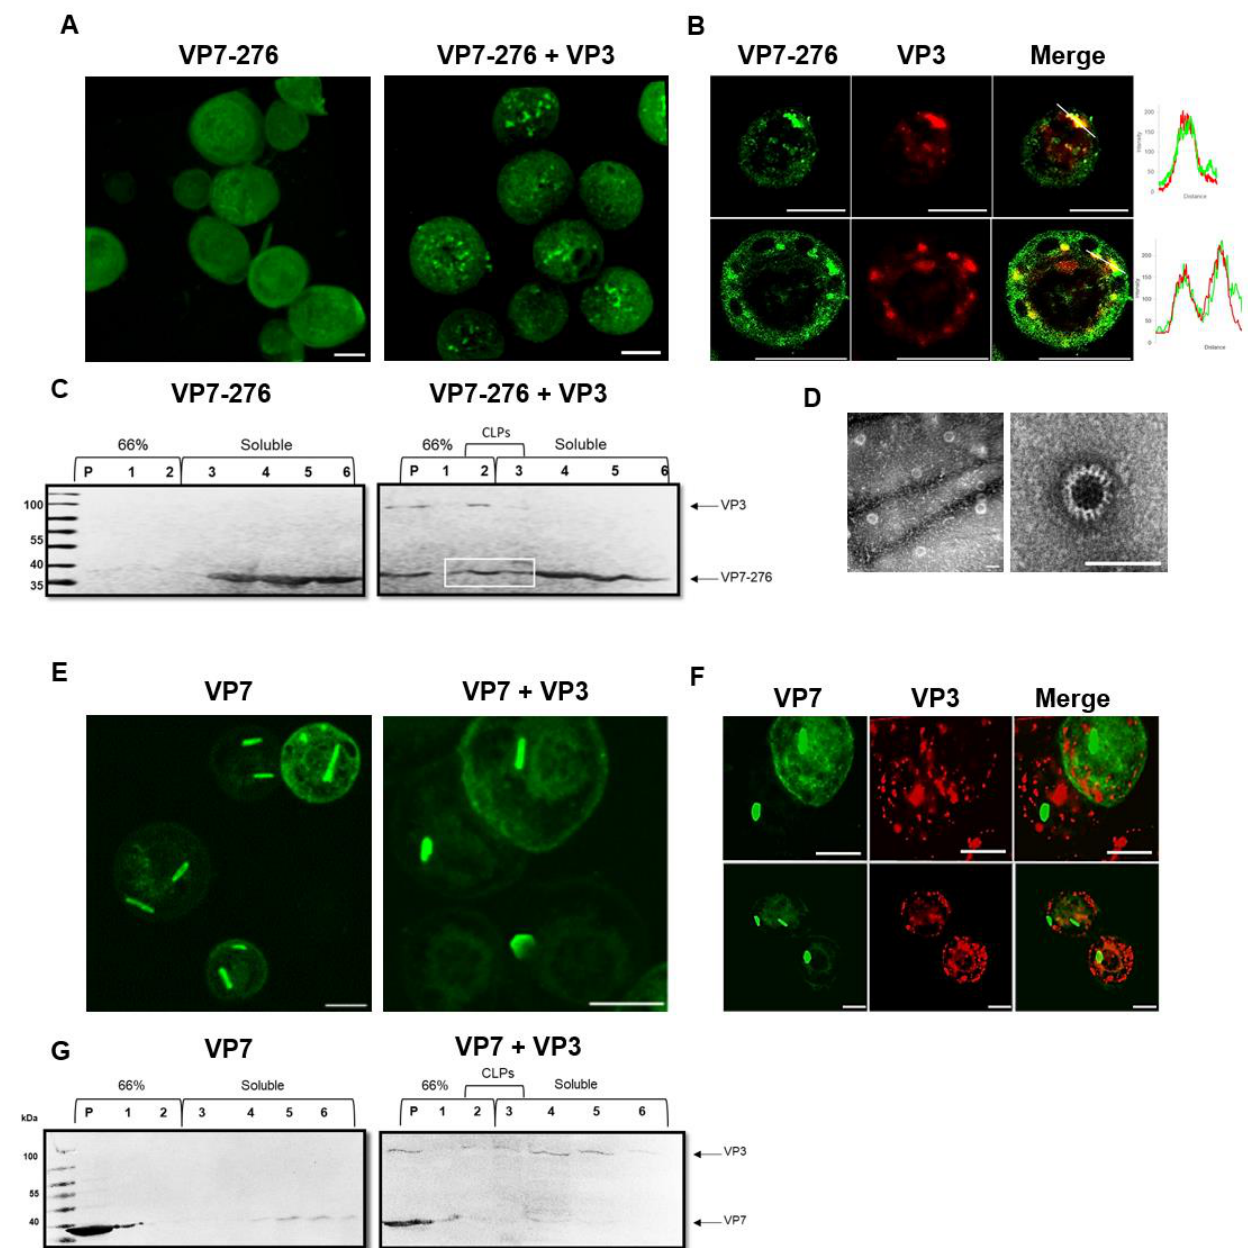
Figure 4. Examination of the VP7-276 interaction with VP3 to form CLPs: ( A ) Intracellular distribution of VP7 in cells expressing VP7-276 alone ( left ) and in the presence of VP3 ( right ). Cells were fixed at 48 hpi and labelled with anti-VP7 primary antibodies and Alexa Fluor 488 conjugated secondary antibodies. ( B ) Colocalisation analysis of the VP7-276 interaction with VP3 by indirect immunofluorescence and LSCM. Cells co-expressing VP3 and VP7-276 were co-labelled with primary antibodies against VP3 (rabbit) and VP7 (guinea pig), and secondary antibodies Alexa Fluor 633 conjugated anti-rabbit (red) and Alexa Fluor 488 conjugated anti-guinea pig (green), respectively. Two examples given, each with split images. Colocalisation of VP7-276 and VP3 in merged images is observed in yellow and was confirmed by measuring the fluorescence intensity of each channel along the white line drawn across a region of interest. Plots of fluorescence intensity vs. distance of the green and red channels are represented on the right. Scal e bars represent 10 μm. ( C ) Western blot analysis of the solubility profile of VP7-276 (left) and VP7-276 in the presence of VP3 (right) from a 40% and 66% sucrose discontinuous step- gradient. Pellets (P) and 500 μL fractions (1 to 6) , collected from a 40% and 66% sucrose discontinuous step-gradient, are indicated on the blots. VP7